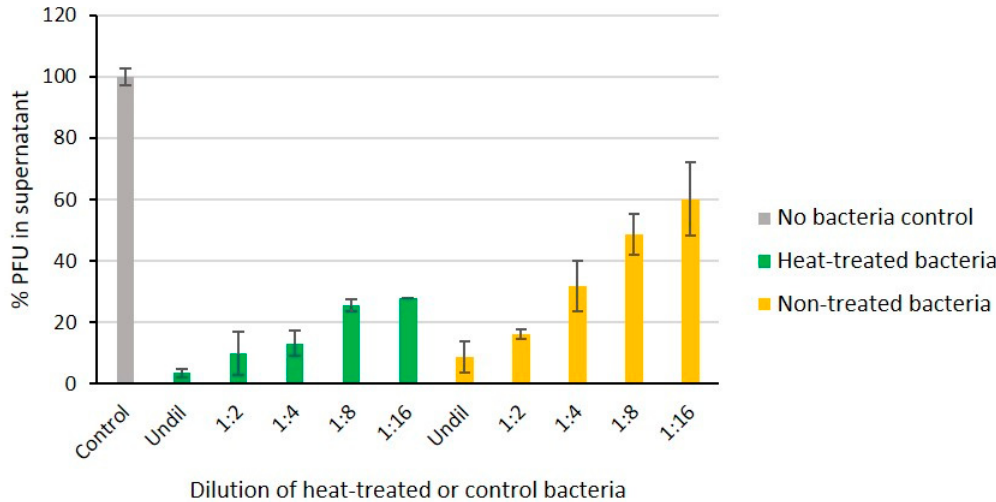
Figure 6. The fPS-65 receptor is heat-stable. Phages were incubated 15 min with different dilutions of heat-treated and non-treated bacteria. Shown are percentages of free phages in the supernatants after centrifugation when compared to no-bacteria control set to 100%. The boiled bacteria adsorbed the phages as well as or better than viable bacteria indicating that the phage receptor is intact. Error bars represent the standard deviations for the average plaque numbers in two parallels of two independent experiments.